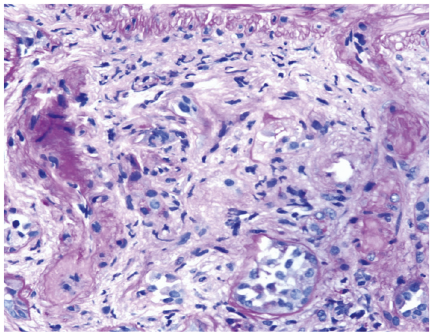
Figure 3: Figure demonstrating arteriolar thrombotic microan- giopathy.